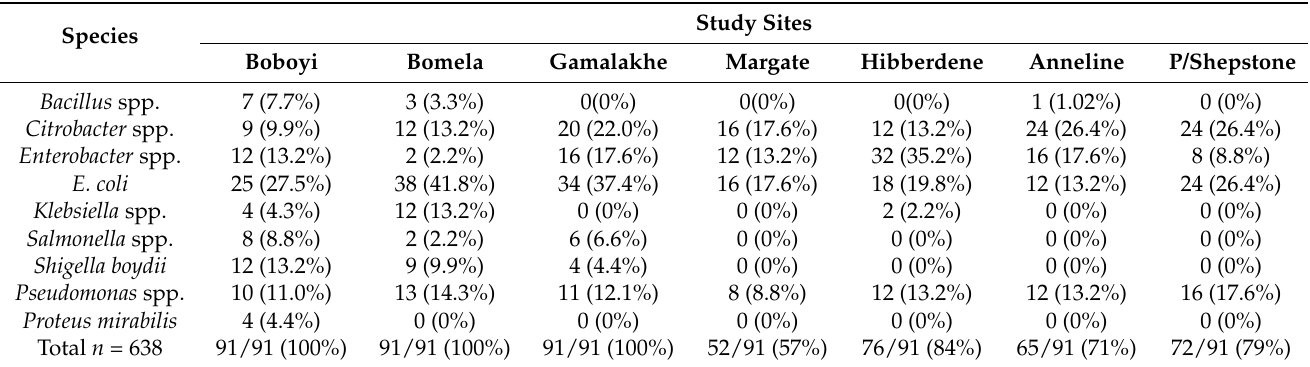
Table 3. The prevalence of selected bacterial species in drinking water of the study areas in the Ugu District Municipality, KZN.